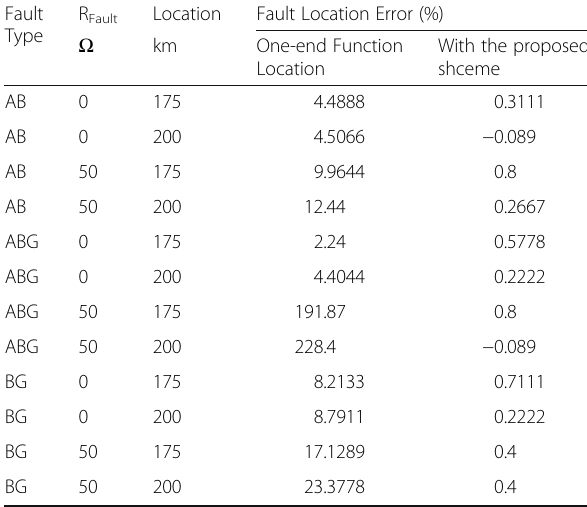
Table 4 Comparison of accuracy of different fault between